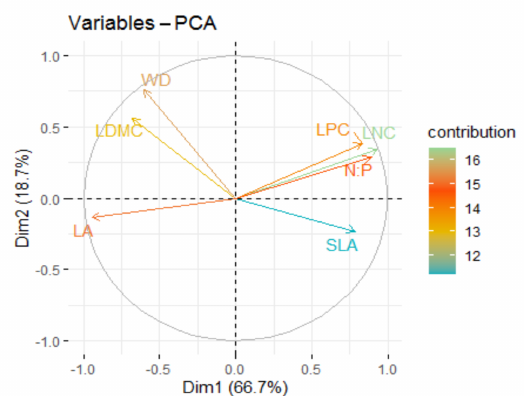
Figure 2. Principal component analysis of variables. The arrow line of the variables is plotted as the correlation coefficients between them and the first two principal components in the unit circle; colors indicate the contributions (%) of variables to the variance in a given principal component.